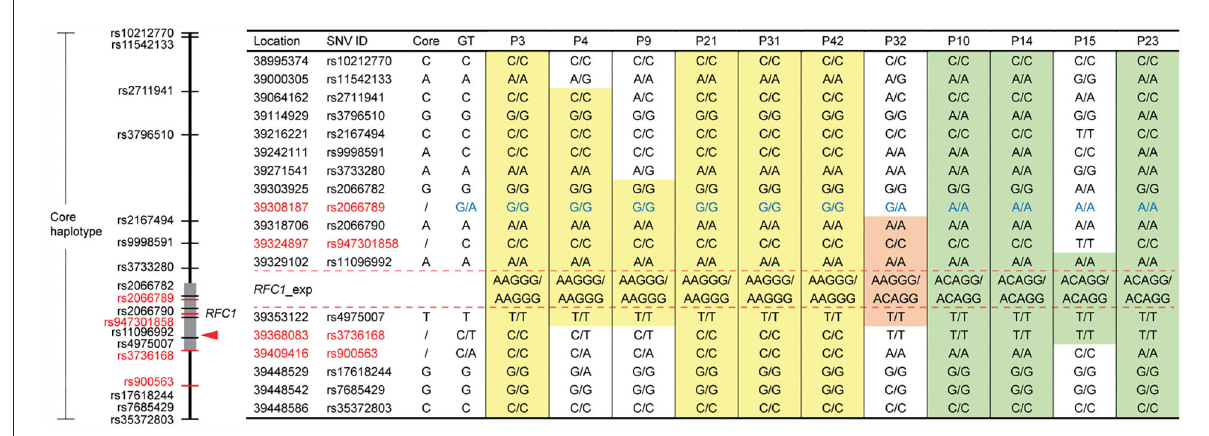
FIGURE4 Single-nucleotide variant (SNV)-based haplotype analysis of 11 cases with different disease-associated RFC1 repeat expansions. The “core haplotype” region, spanning from chr4:38995374 (rs10212770) to chr4:39448586 (rs35372803), is covered by 14 previously applied and 4 new SNV markers (red color). GT: genotype. Respectively, 49.2kb (chr4: 39303925 ∼ 39353122) and 453.2kb (chr4: 38995374 ∼ 39448586) highly conserved homologous haplotype blocks are identified from all six cases carrying [(AAGGG)exp/(AAGGG)exp] (yellow background) and 3/4 of cases with [(ACAGG)exp/(ACAGG)exp] (green background). P32 carrying [(AAGGG)exp/(ACAGG)exp] shares an identical haplotype block (chr4: 39318706 ∼ 39353122; light red background) with other repeat expansion subtypes. Genotype of rs2066789 (G/A) is haplotype specific (blue color), and the haplotype of P15 is